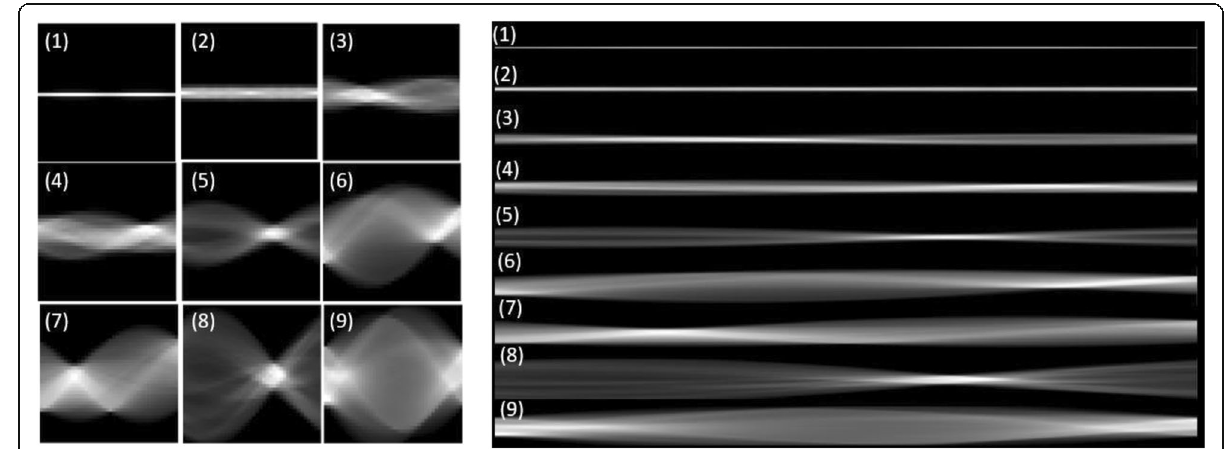
Fig. 4 Examples of sinograms projected from the initial nodule candidates in Fig. 2 with different view numbers: 40 views (left) and 640 views (right)